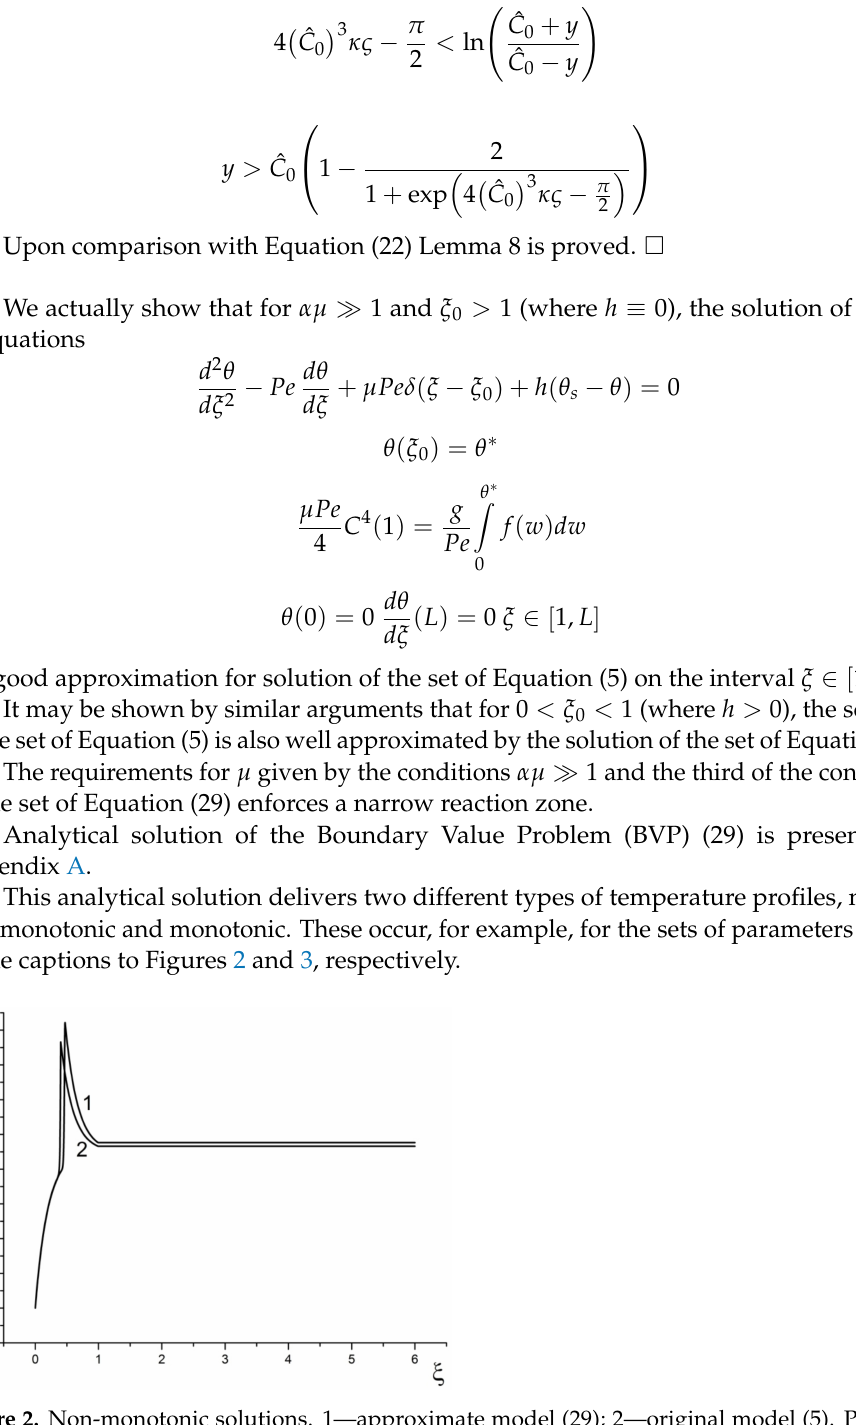
Figure 2. Non-monotonic solutions. 1—approximate model (29); 2—original model (5). Pe = 135; A = 2.75 × 10 − 18 ; Ar = 0.012; h s = 7.14 × 10 2 ; θ s = 90; g = 1.0 × 10 − 20 ; µ = 91.67; ξ 0 =